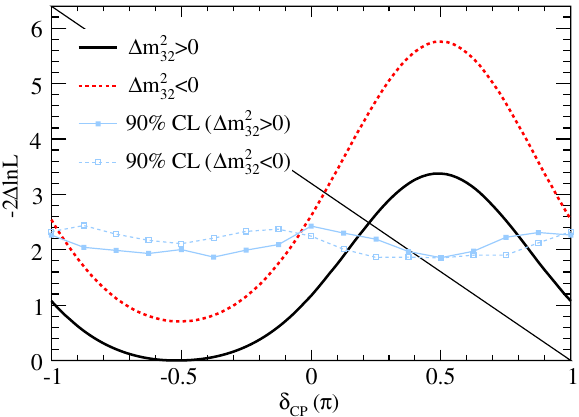
Fig. 59 The − 2 Δ ln L value as a function of δ CP with the reactor θ 13 constraint for normal and inverted hierarchies from [58]. The likelihood is marginalized over θ 13 , θ 23 and Δ m 2 . The 90% CL is evaluated using 32 the Feldman–Cousins method, where the δ CP regions with values above the 90% CL lines are